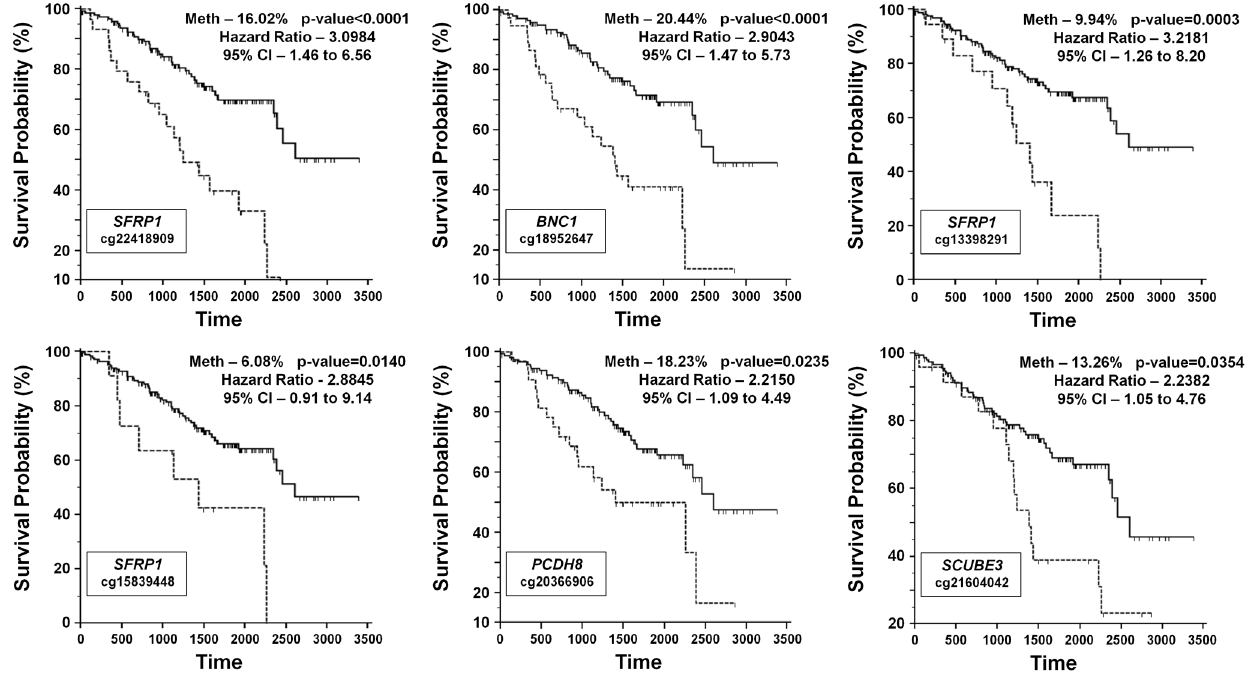
Figure 3. Kaplan-Meier survival curves for the hypermethylated probes from the HumanMethylation27 BeadChip cohort. Kaplan- Meier survival curves were calculated for all of the tumor-specific hypermethylated probes within the HumanMethylation27 BeadChip cohort and these graphs represent the probes for which the p-value remained significant after false discovery rate (FDR) correction for multiple analyses. The percentage of hypermethylation (Meth) is representative of the 181 CCRCC tumor/normal pairs for which clinical information was available. The relevant BeadChip probe is listed with the gene name.